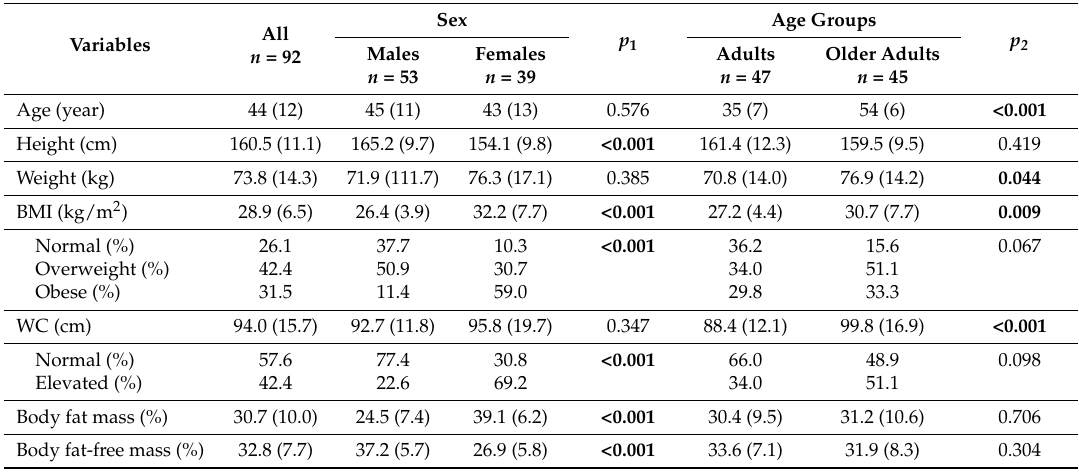
Table 1. Descriptive characteristics of the participants.